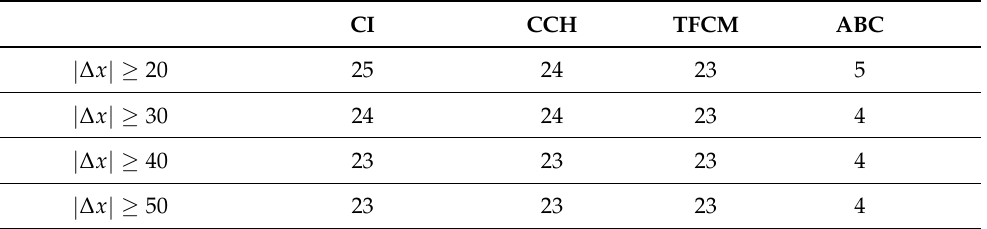
Figure 16. Matching performance in Skiing dataset. Table 7. Number of mismatches in 30